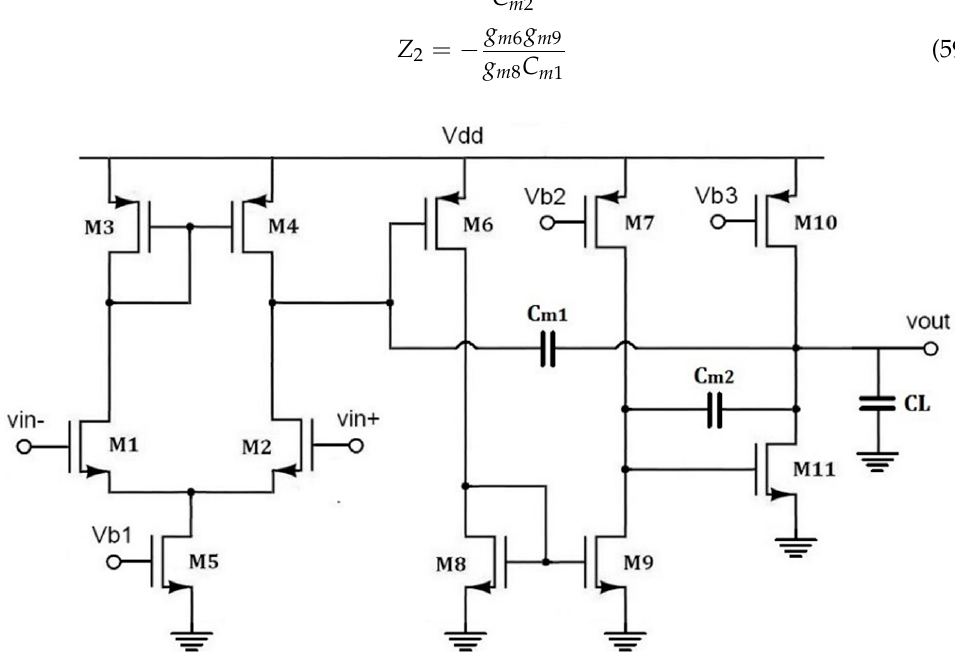
- Table 9. Numerical results for Circuit 3. Parameter